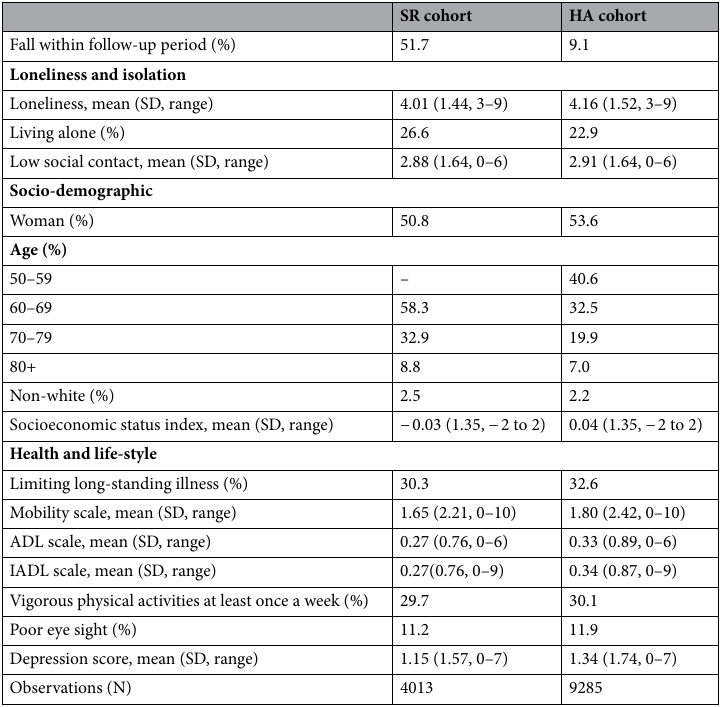
Table 1. Characteristics of the self-reported (SR) cohort and the hospital admission (HA) cohort at the